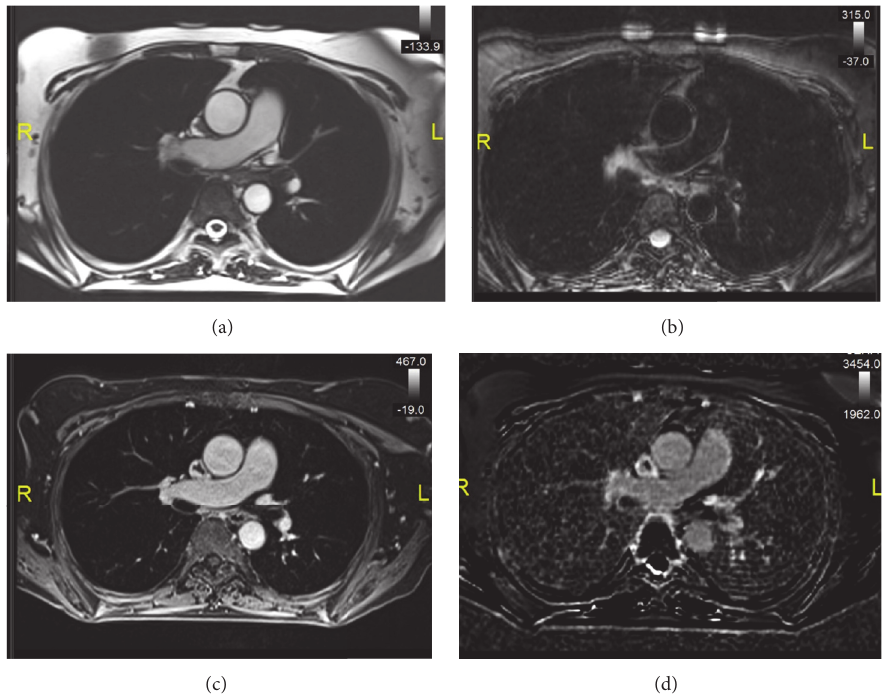
Figure 3: Cardiac magnetic resonance evaluation. (a) Axial SSFP image shows a hypointense structure conforming to the medial lower SVC wall. (b) Axial T2 SPAIR MR image shows isointense T2 signal within the structure. (c) Axial T1 postcontrast image demonstrates a well-defined intravascular filling defect along the SVC wall. (d) Late gadolinium enhancement phase sensitive inversion recovery image demonstrates hypoenhancement of the intravascular structure. Findings are compatible with bland